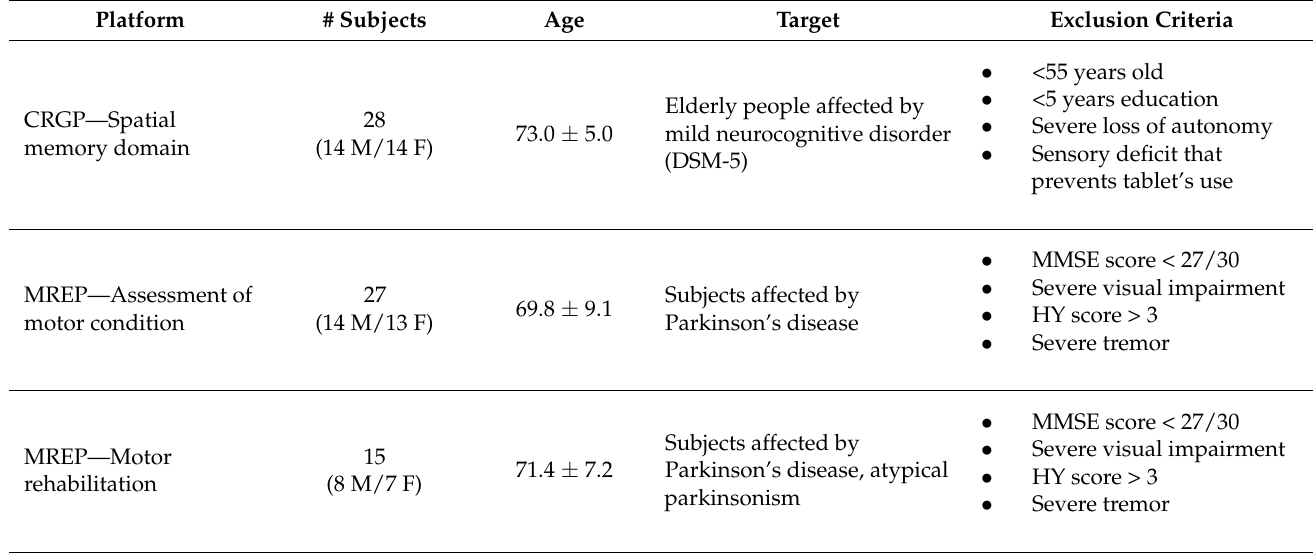
Table 4. Characteristics of the experimental